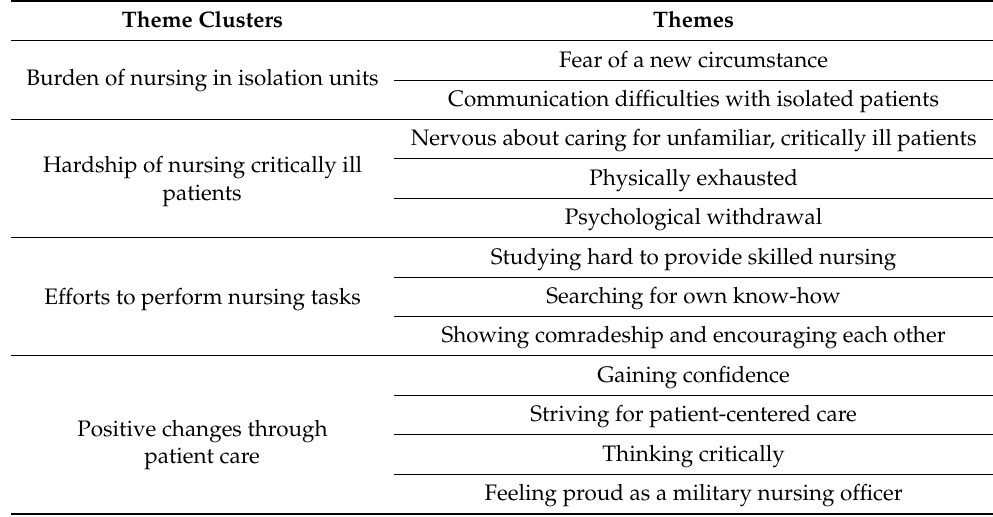
Table 3. Themes and theme clusters of the